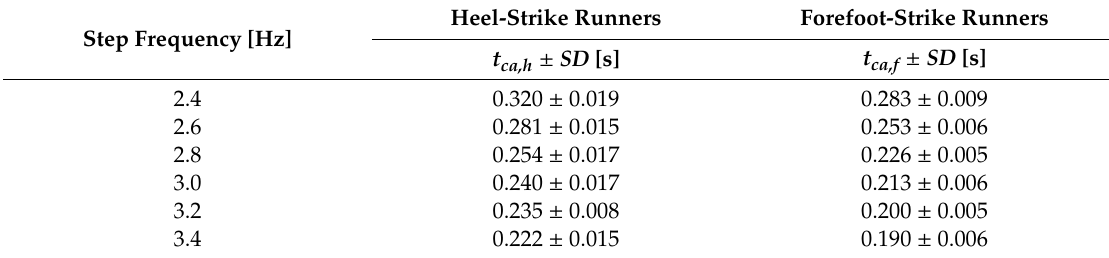
Table 2. t ca,h , t ca,f indicators of the F VGRF curve (mean ± standard